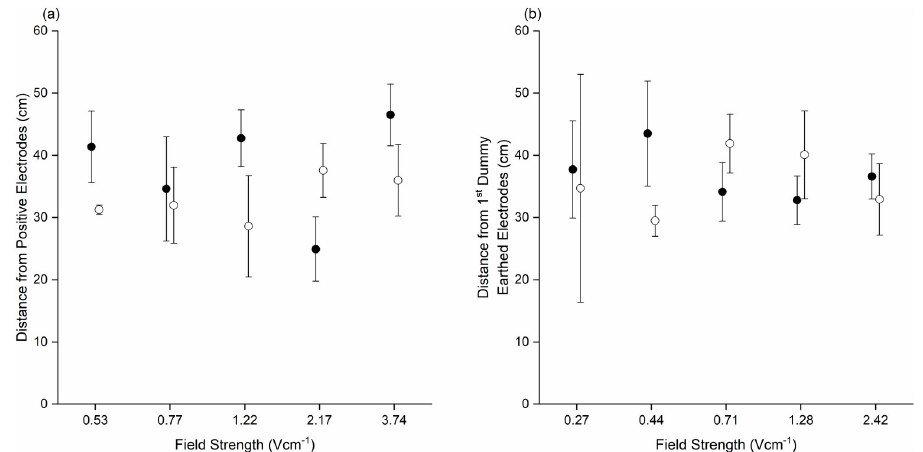
Fig 5. Distance (cm) of initial response [ ± SE] from positive and 1 st dummy earthed electrodes in both (a) HEF and (b) LEF route, respectively, for upstream migrating juvenile eel in the 2 Hz (solid circles) and 10 Hz (clear circles)